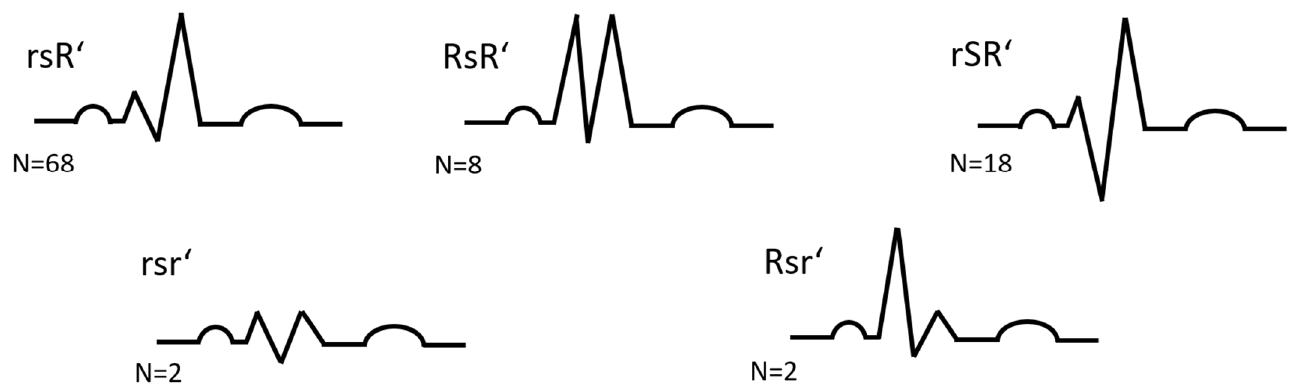
Figure 1. RBBB morphologies, lead V1 (RBBB = right bundle branch block).